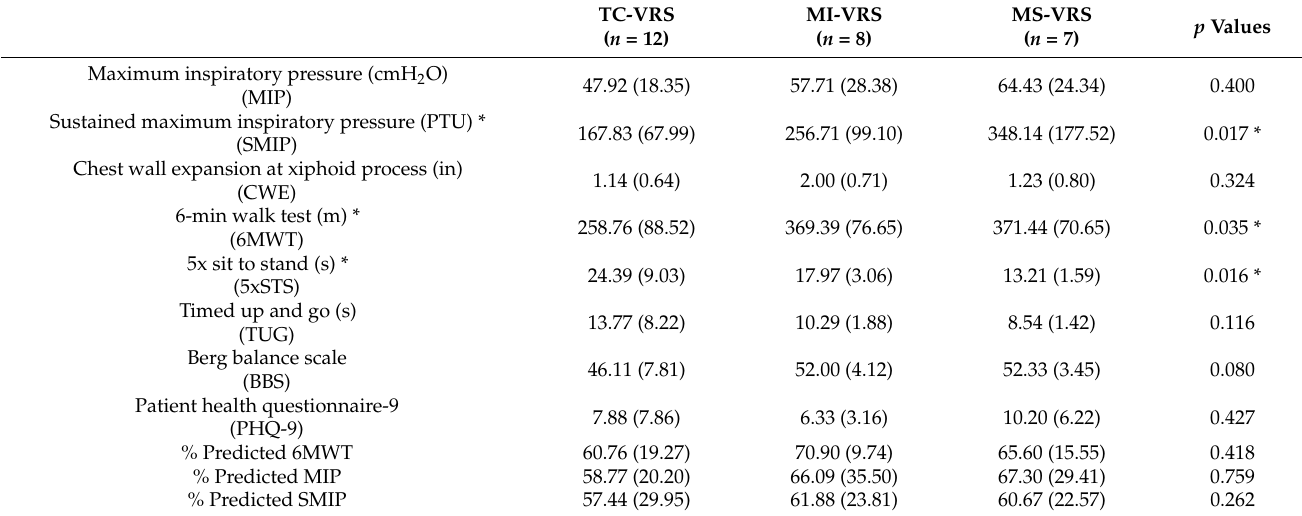
Table 2. Outcome measures by type of surgery: mean (SD) or n (%).